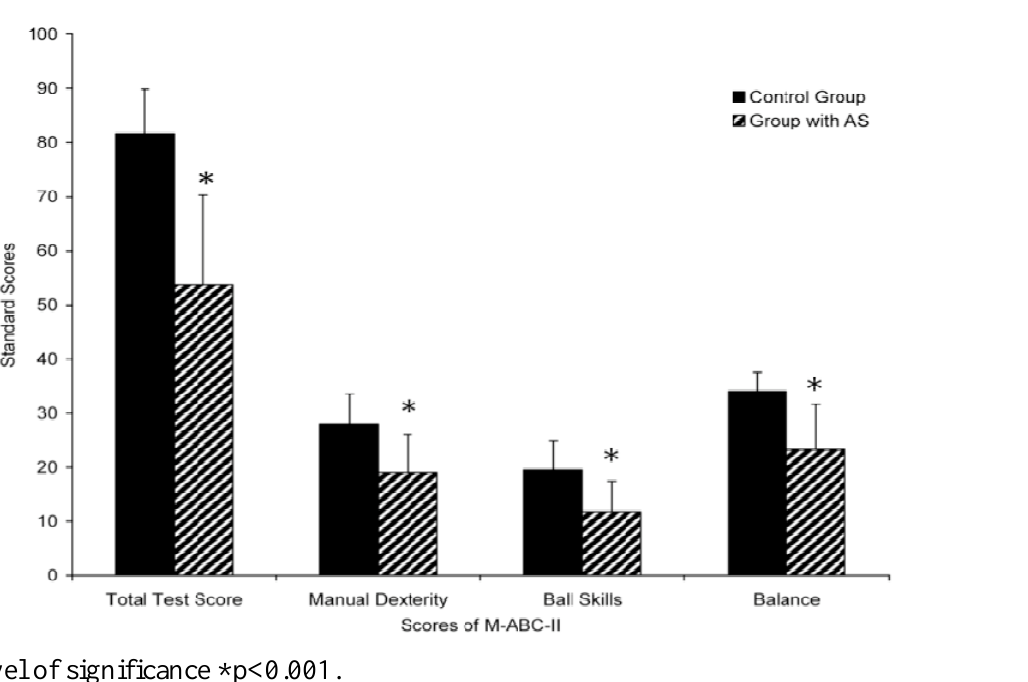
Figure 1. Mean component - and total test scores (+SD) of the M-ABC-II for both group with AS (N = 30) and control group (N = 30).